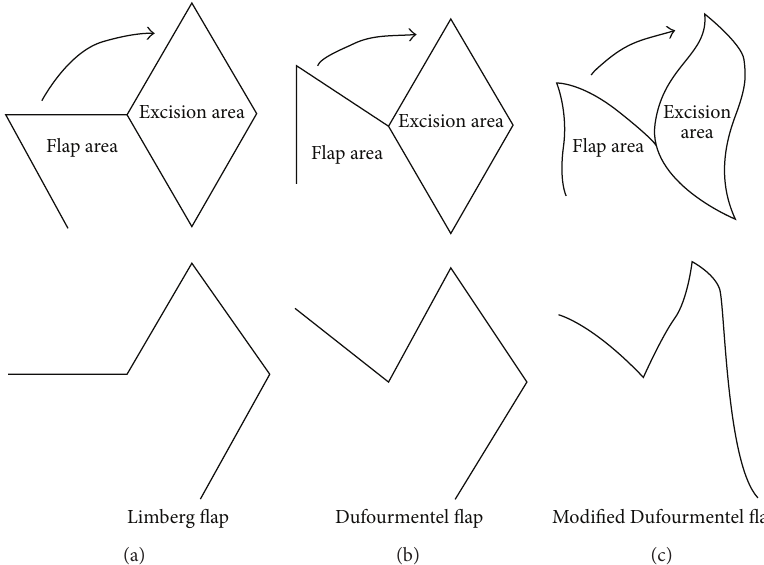
Figure 4: Shows the mapping schemes for the Limberg (a), Dufourmentel (b), and modified Dufourmentel flaps (c) (the final view of the flap procedure is shown at the